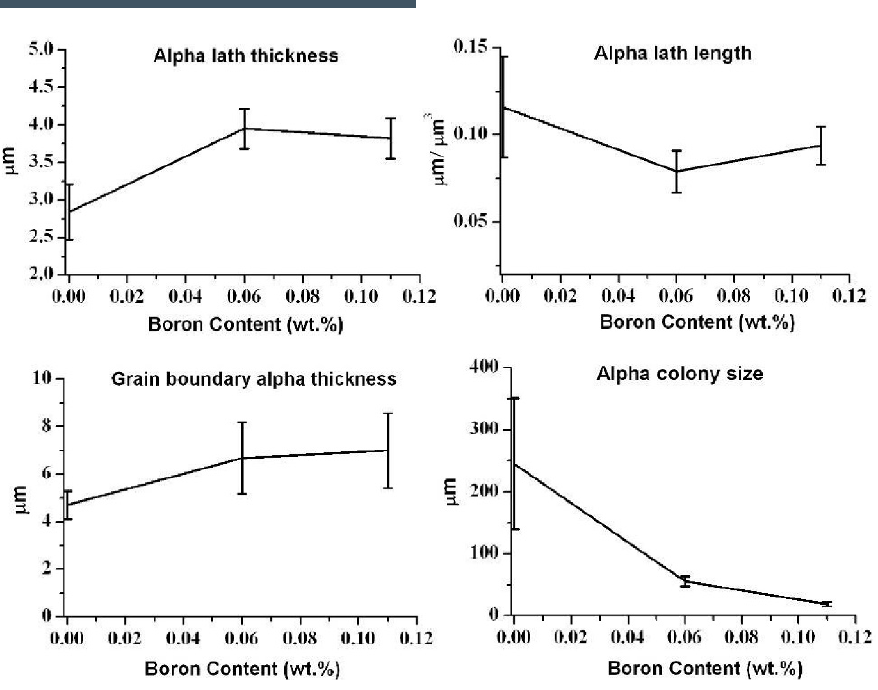
Figure 5. Results from quantitative measurements of selected microstructural features in cast Ti-64 with varying boron content. Each feature was measured 15 times and the average out of each set of measurements is here presented, including the corresponding standard